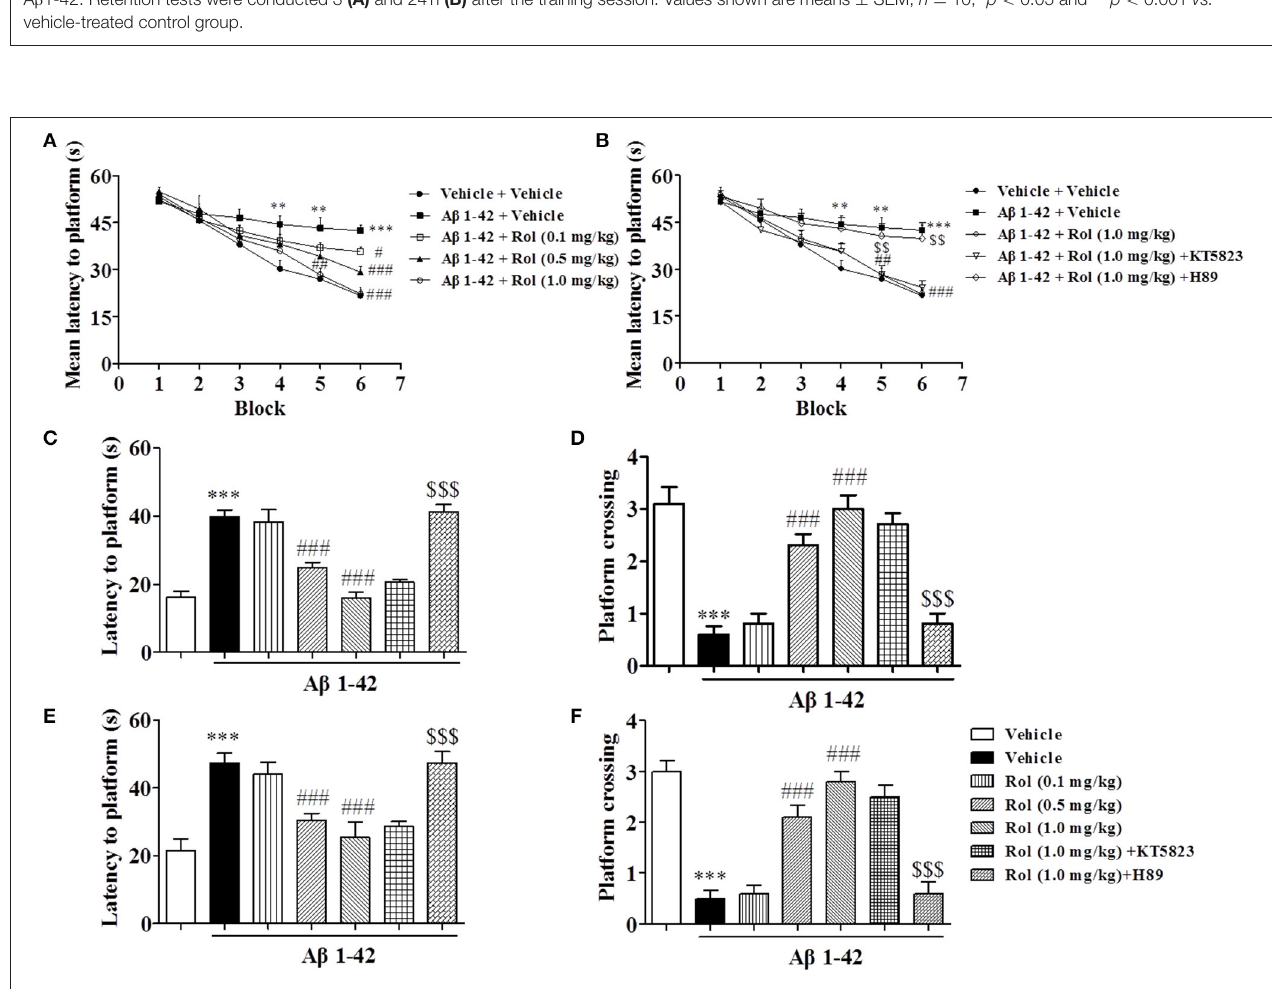
FIGURE 3 | The effects of rolipram on A β 1-42-induced memory impairment in the Morris water-maze test in mice. One and a half months after microinfusion with A β 1-42 into cerebroventricle, mice were administrated with rolipram for 14 days. H89 and KT5823 were pretreated 30min before rolipram administration every day. During the acquisition trials of the water maze task, learning curve was tested 24h after last treatment with rolipram (A,B) . The probe trial was conducted 1 and 24h after training, the latency to reach the platform (C,E) and the number of platform crossings (D,F) were determined. Values shown are means ± SEM, n = 10; ** p < 0.01 and *** p < 0.001 vs. vehicle treated sham group. # p < 0.05, ## p < 0.01, and ### p < 0.001 vs. vehicle-treated A β group. $$ P < 0.01 and $$$ P < 0.001 vs. rolipram (1.0mg/kg)-treated A β group.